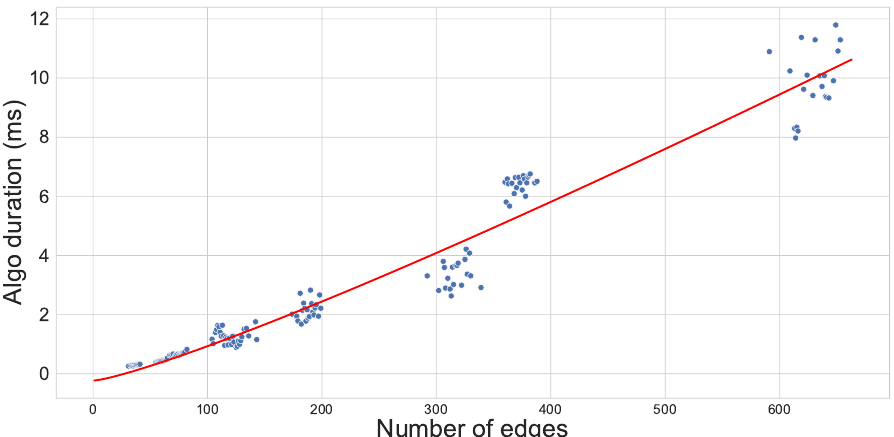
Figure 15. Log regression of the execution time according to the number of edges. When the algorithm time is predicted, we found that the number of edges ( β = 0.0020; p < 0.001) is a significant